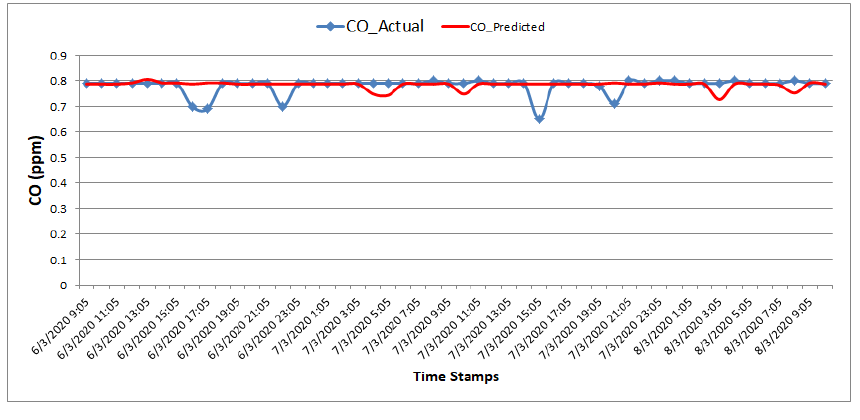
Figure 17. Hourly Predicted values of CO vs. Actual